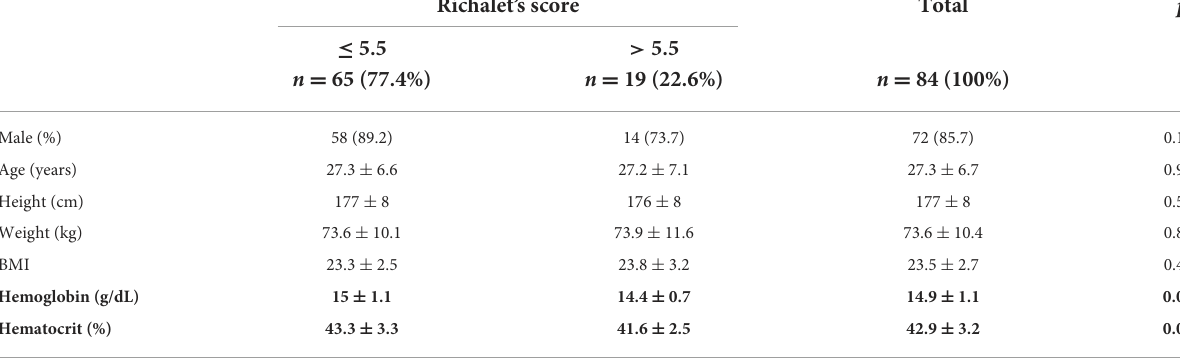
TABLE 4 Clinical and biological characteristics according to the Richalet’s score; BMI, body mass index. Richalet’s